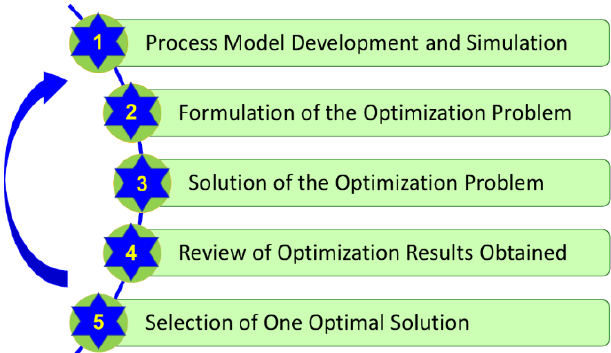
Figure 1. Steps in the systematic procedure for the multi-objective optimization (MOO) of processes; curved arrow on the left emphasizes the need for repetition from an earlier step.